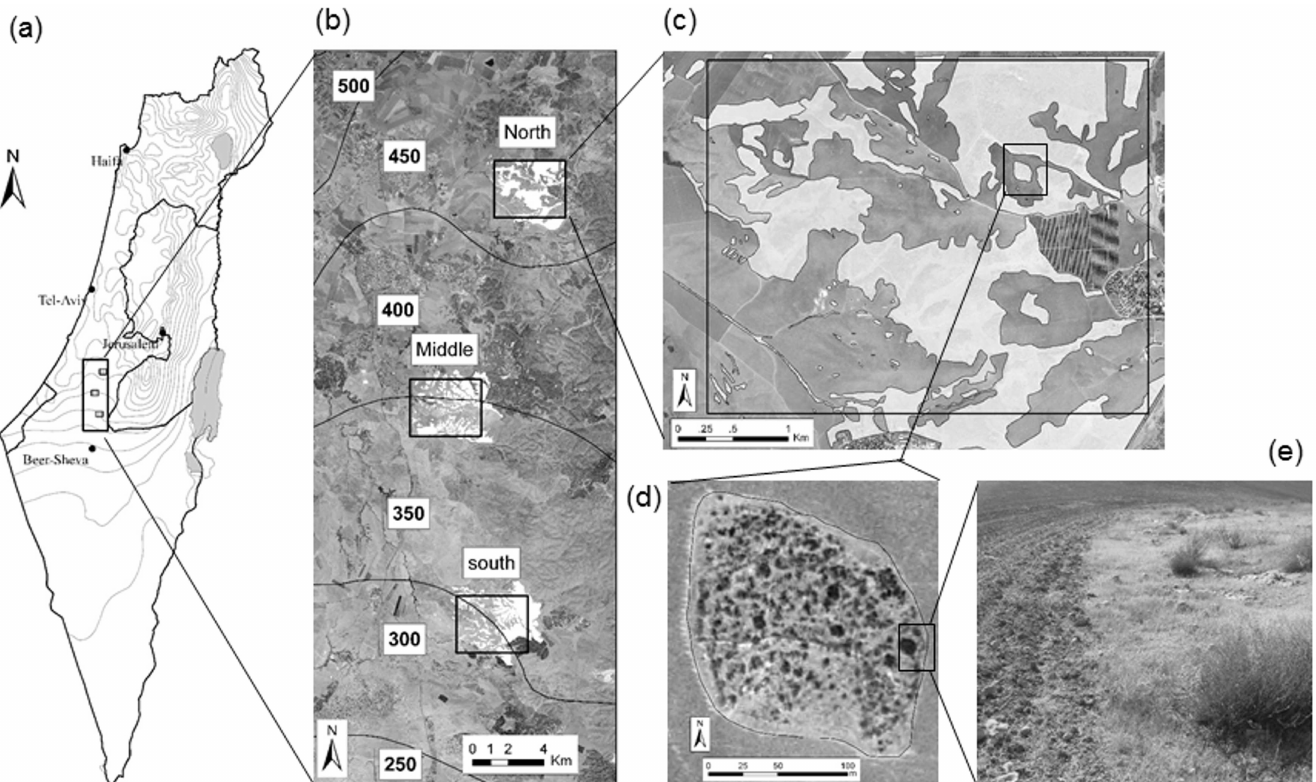
Fig 1. Hierarchical scalesof the study system. (a) The sharp precipitation gradientof Israel and location of Southern JudeaLowland(SJL) along the gradient. (b) The north, middleand south landscapes within SJL. Note the sharp declinein mean annualprecipitation along a short gradientof 30 km. (c) The north landscape—the distribution of remnant natural patches within the agricultural matrix. (d) A patch, with its specific attributes of area, shape, and internalheterogeneity. (e) One complex habitat (perennial shrub, low right corner) surrounded by a simple habitat (annualplants < 15 cm tall), and the contrast with the agriculturalmatrix during the